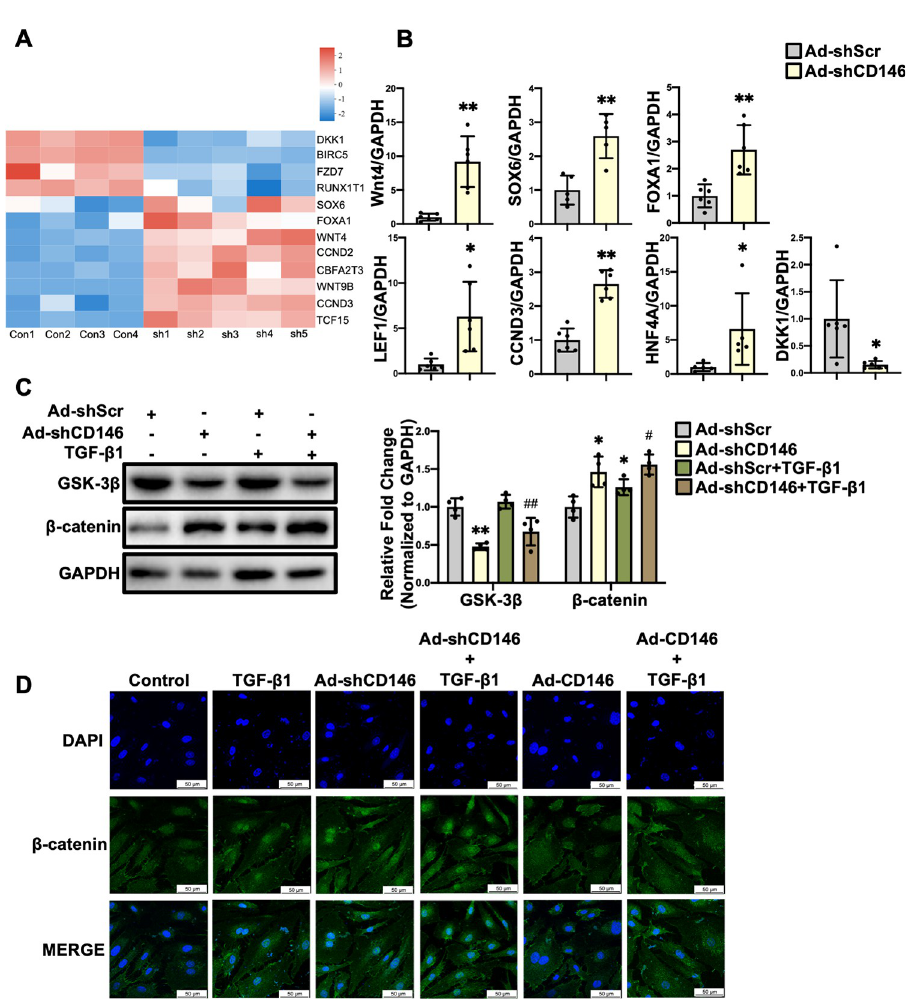
Fig 7. Knockdown of CD146 leads to the activation of canonical Wnt/ β –catenin pathway in HUVECs. A Heatmap depicting the differentially expressed genes related to Wnt signaling pathway. B The mRNA levels of Wnt4 , SOX6 , FOXA1 , LEF1 , CCND3 , HNF4A and DKK1 were measured by qRT–PCR analysis. C HUVECs were infected with Ad– shScr or Ad–shCD146 for 48h followed by TGF– β 1 (10 ng/ml) treatment for 48h. The protein levels of GSK–3 β and β – catenin were measured by Western blot analysis. GAPDH served as an internal control. D HUVECs were infected with Ad–shCD146 or Ad–CD146 for 48 h followed by TGF– β 1 (10 ng/ml) treatment for 6 h. Representative immunofluorescence images of β –catenin translocation in HUVECs (scale bars indicate 50 μ m). Green represents β – catenin; blue represents nuclei. � P < 0.05, �� P < 0.01 vs . Ad–shScr, # P < 0.05, ## P < 0.01 vs . Ad–shScr+TGF– β 1. Ad–shScr: